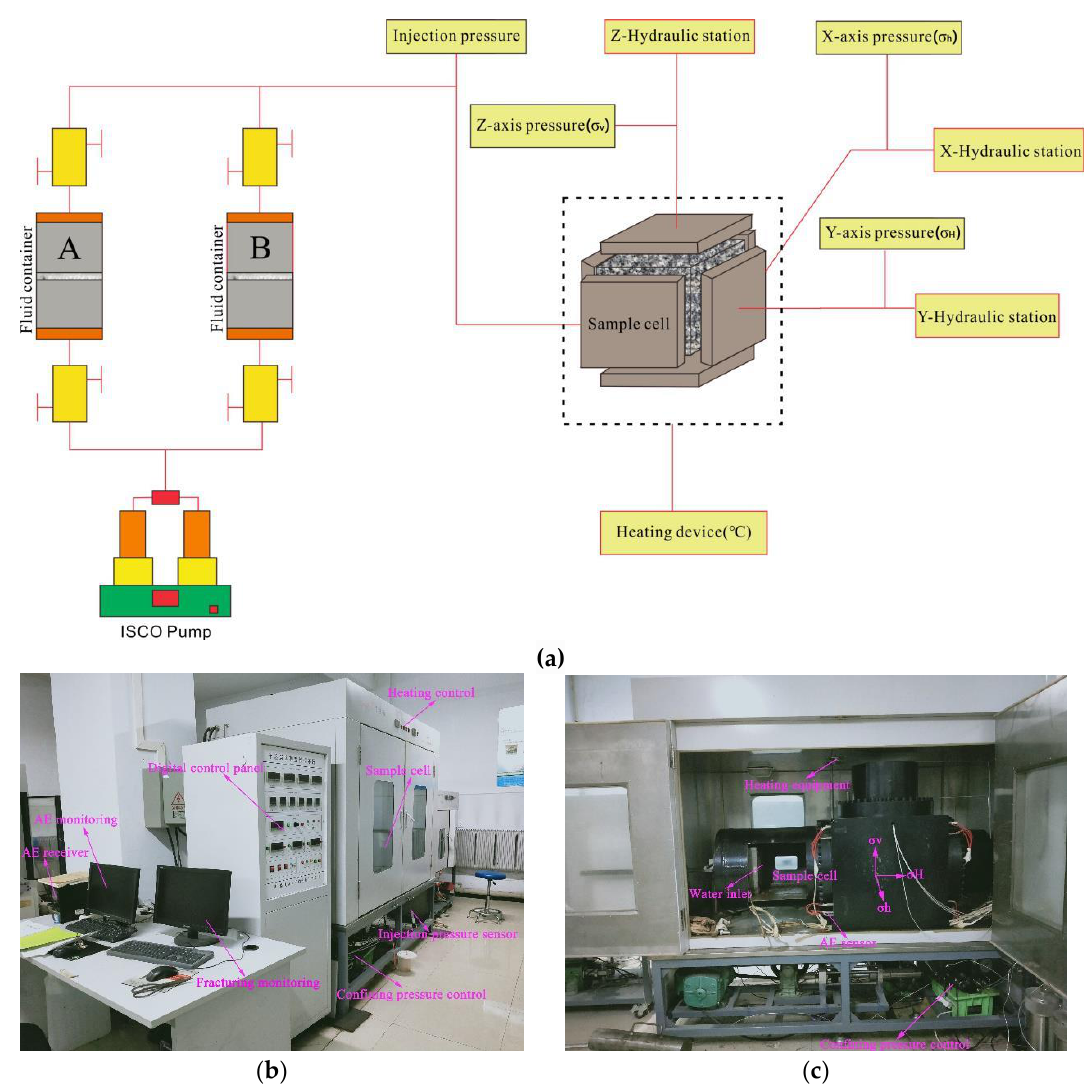
Figure 6. ( a ) Schematic of the true tri-axial fracturing system; ( b ) close-up view of the system and ( c ) sample cell and schematic diagram of the loading method.